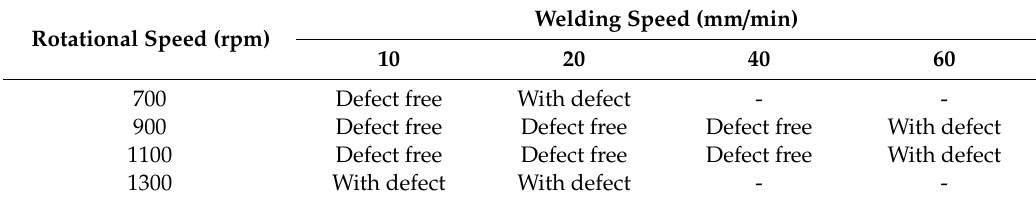
Table 1. Welding parameters matrix and corresponding macro-quality of joint.